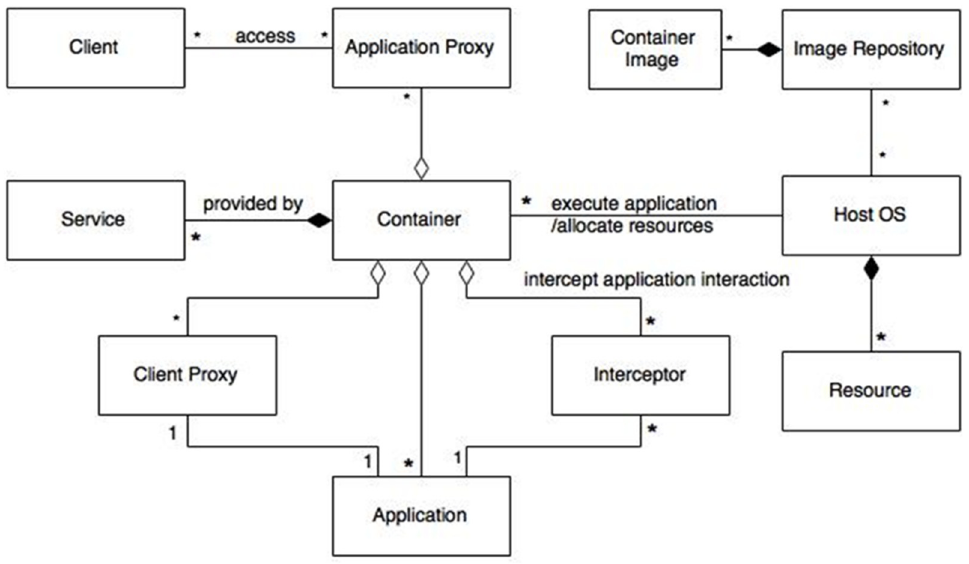
Figure 5. Two containers sharing one OS.